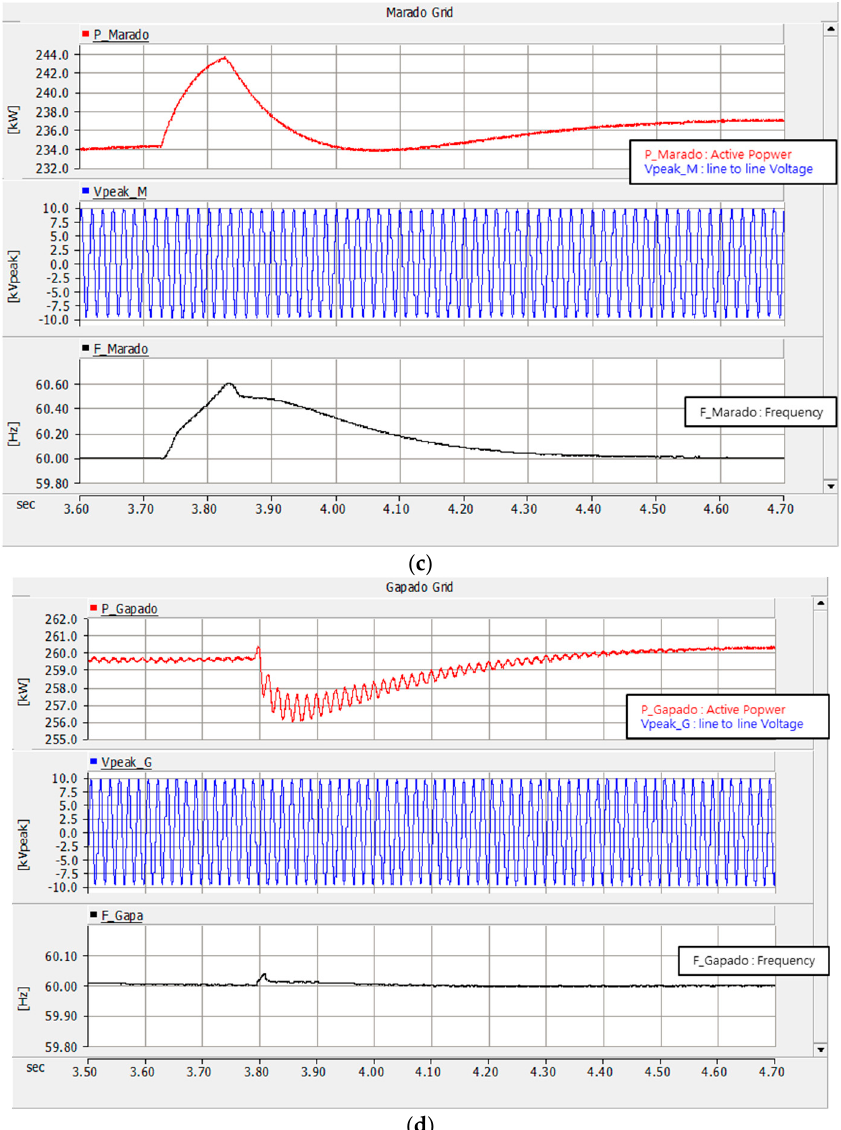
Figure 13. ( a ) Active power output of grid; ( b ) Variation of active power of diesel generator; ( c ) Marado Island power grid; ( d ) Gapado Island power grid; through the PV penetration.